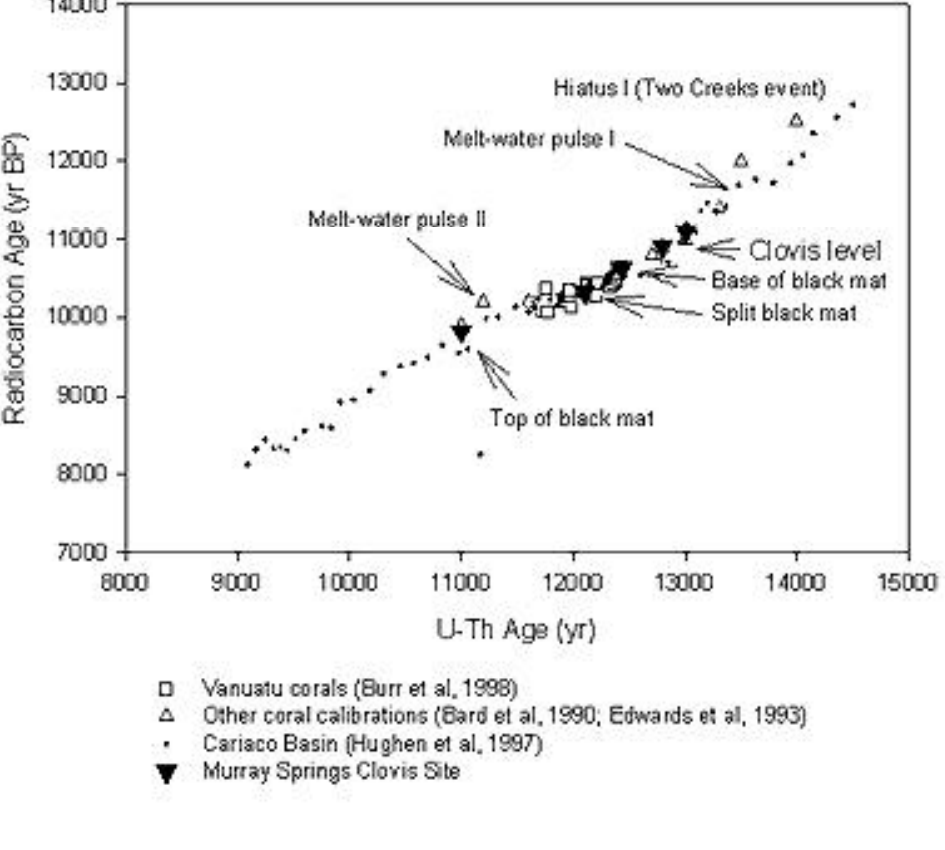
FIGURE 4. Relative dating of the expansion of Clovis man in the New World, compared to climatic events during the Late Glacial period. The expansion of early man in the New World is compared to climatic events, especially the sea-level rise determined by Edwards et al.[34] from corals in New